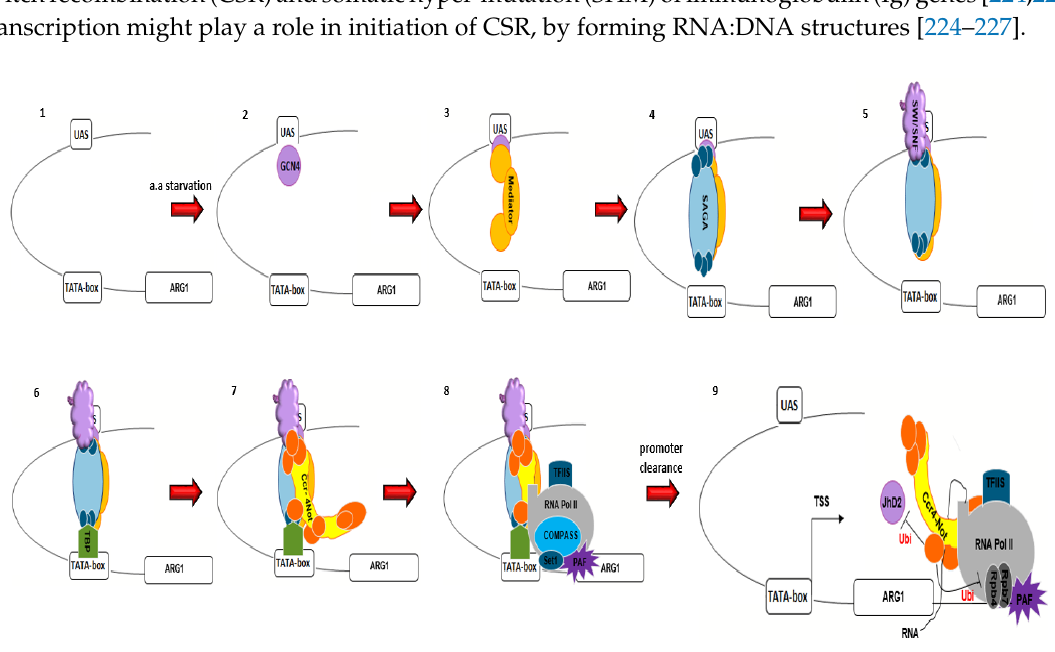
Figure 2. The presence of Ccr4–Not complex in pre-initiation and elongation complexes. In